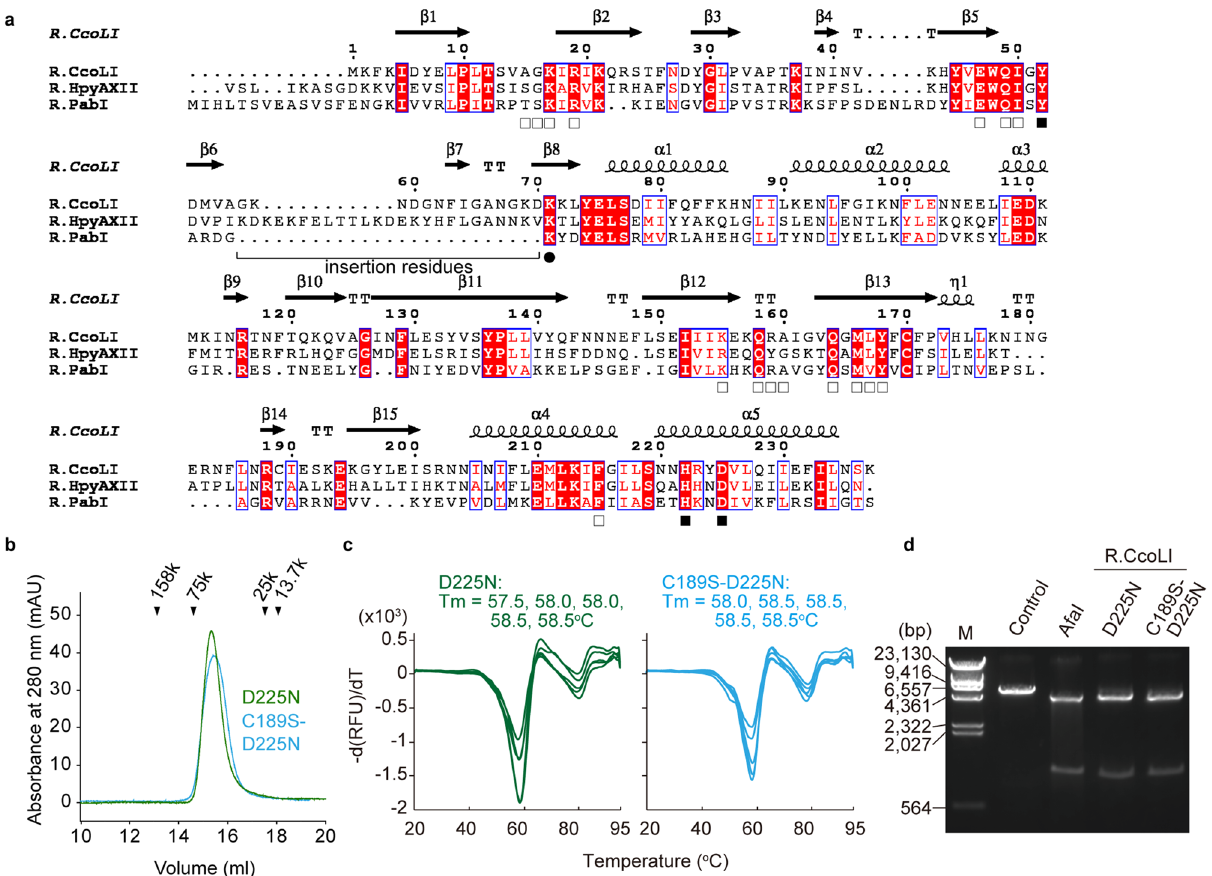
Figure 1. Preparation of R.CcoLI. ( a ) Sequence alignment of R.PabI homologs (R.CcoLI, WP_002830209; R. HpyAXII, ACI43084.1; R.PabI, CAB49082). Invariant residues are highlighted with red boxes, and conserved residues are shown in red text. The secondary structure of R.CcoLI (chain A) is indicated by helixes (α and 3 10 (η)-helices), arrows (β-strand), and TT (β-turn). The catalytic triad and base recognition residues of R.PabI are marked with black and open squares, respectively. The residue that is predicted to be involved in the DNA lyase activity of R.CcoLI (Lys71) is marked with a circle. Insertion residues that are not conserved in R.PabI are indicated by a black line. ( b ) Gel filtration of the R.CcoLI(D225N) ( M r = 28,007) and R.CcoLI(C189S-D225N) ( M r = 27,991) mutants. The peak positions of the marker proteins are indicated by black triangles. Molecular weights of the R.CcoLI(D225N) and R.CcoLI(C189S-D225N) mutants were estimated to be 56 k and 53 k, respectively. Data are representative of three independent experiments. ( c ) Thermostability assay of R.CcoLI mutants. The melting curves of the R.CcoLI(D225N) mutant and the R.CcoLI(C189S-D225N) mutant are shown by green and cyan lines, respectively (n = 5). RUF, relative fluorescence unit. ( d ) DNA cleavage activities of the R.CcoLI(D225N) and R.CcoLI(C189S-D225N) mutants. The substrate DNA was treated with R.CcoLI mutants or AfaI, which cleaves the DNA duplex at the same site as R.CcoLI. The image is a cropped gel image. The full image is in Supplementary Fig. S7